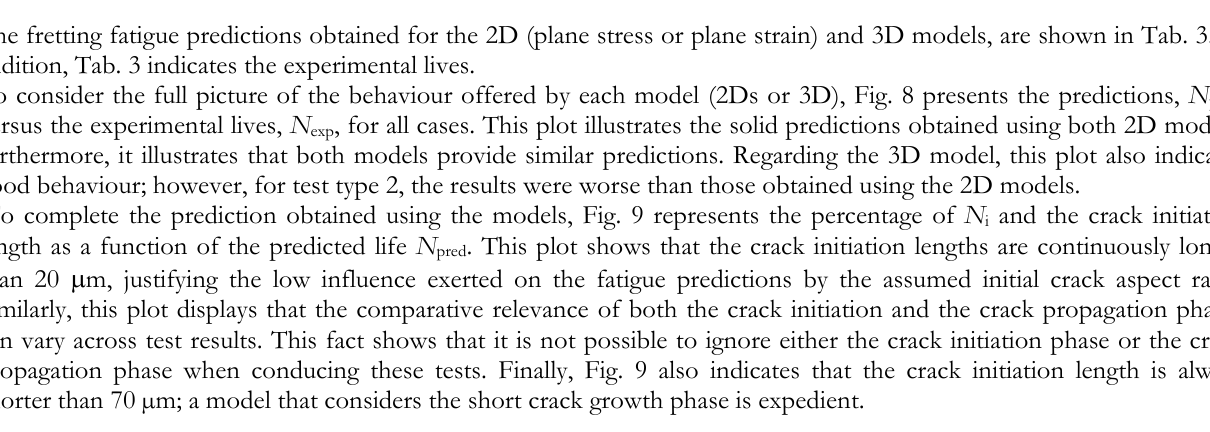
Table 2: Mechanical and fatigue properties for the Al